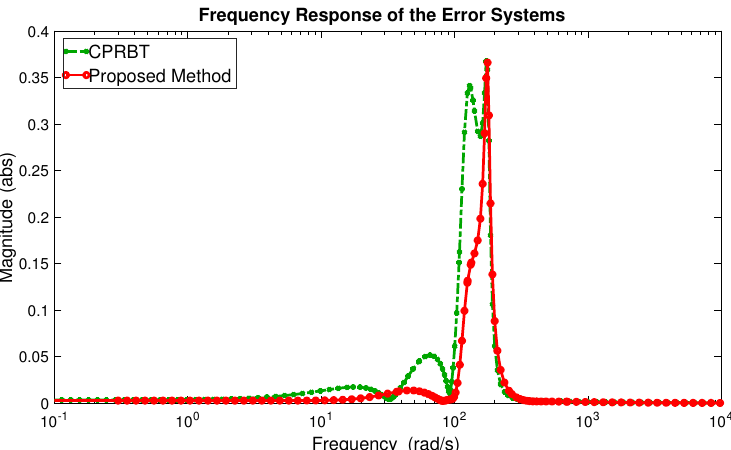
Figure 4. The frequency response of the error system H ( s ) − H r ( s ) obtained from CPRBT and the proposed method in Example